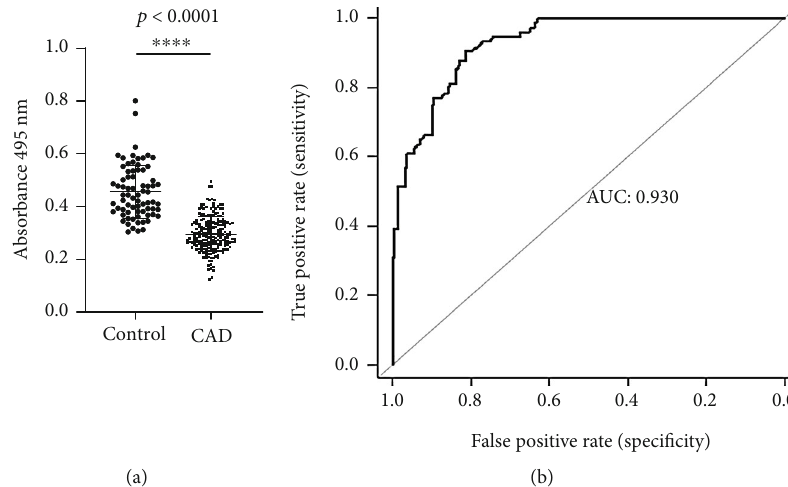
Figure 3: Validation of TTR in CAD Plasma: (a) The enzyme-linked immunosorbent assay of TTR from plasma of CAD patients ( n = 200 ) and control ( n = 50 ) indicated signi fi cant low level with a 1.61-fold p < 0 : 0001 . (b) The ROC plot indicates the individual protein abundance of each group with area under curve AUC: 0.930. The statistical signi fi cance was determined by Student ’ s t -test, p < 0 : 05 .